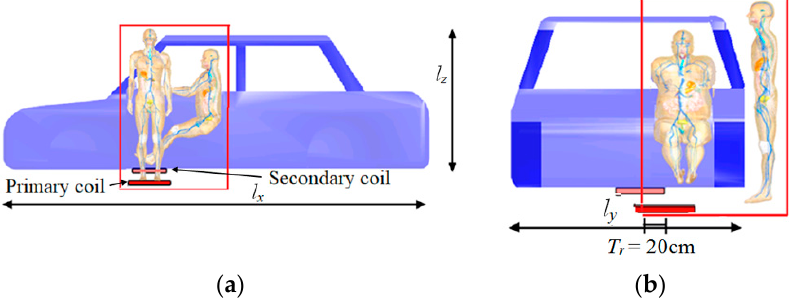
Figure 2. Configuration of Duke and Fats placed near and inside an EV chassis. ( a ) Aligned and ( b ) misaligned coils. The red box is the computational domain for dosimetry assessment.